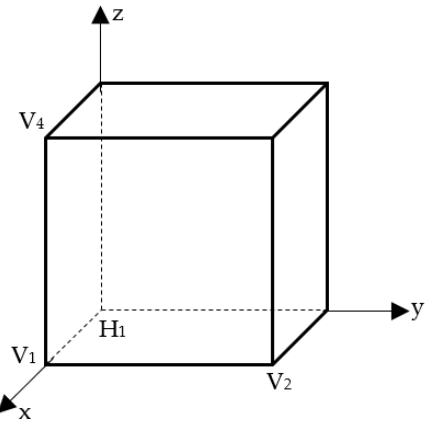
Figure 2. Schematic view of the four vertex nodes V 1 , V 2 , V 4 , and H 1 .